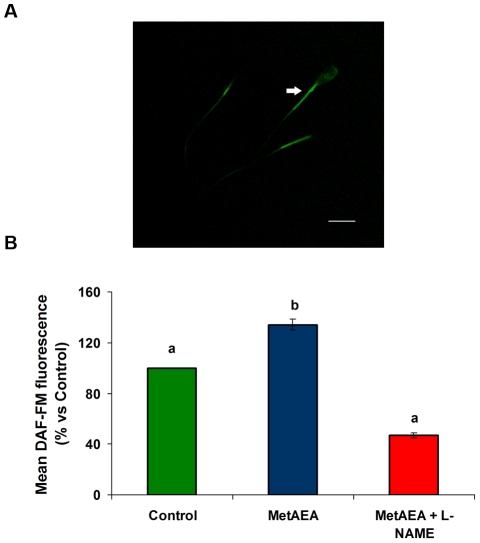
Determination of NO levels in bull spermatozoa.Sperm samples were incubated for 60 min at 38.5°C in 0.3% BSA sp-TALP containing 0.1 mM L-Arginine and 5 µM of DAF-FM diacetate and untreated (control) or treated with MetAEA (1.4 nM), MetAEA+L-NAME (1 µM). Spermatozoa were fixed and the fluorescent complex was measured by flow cytometry. A) A representative photograph showing fluorescence in spermatozoa, indicating the content of intracellular NO (Magnification, ×600); B) Fluorescence data are expressed as mean fluorescence (percentage of control at 45 min incubation, control adjusted to 100%). Data are expressed as mean ± SEM (n = 8). a≠b, p<0.05.